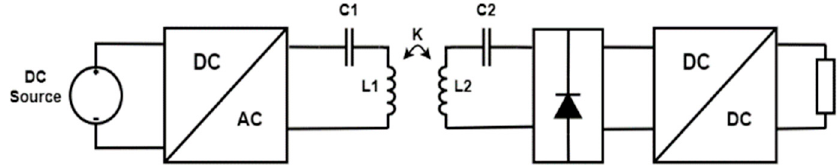
Figure 28. Block diagram of resonant WPT system.